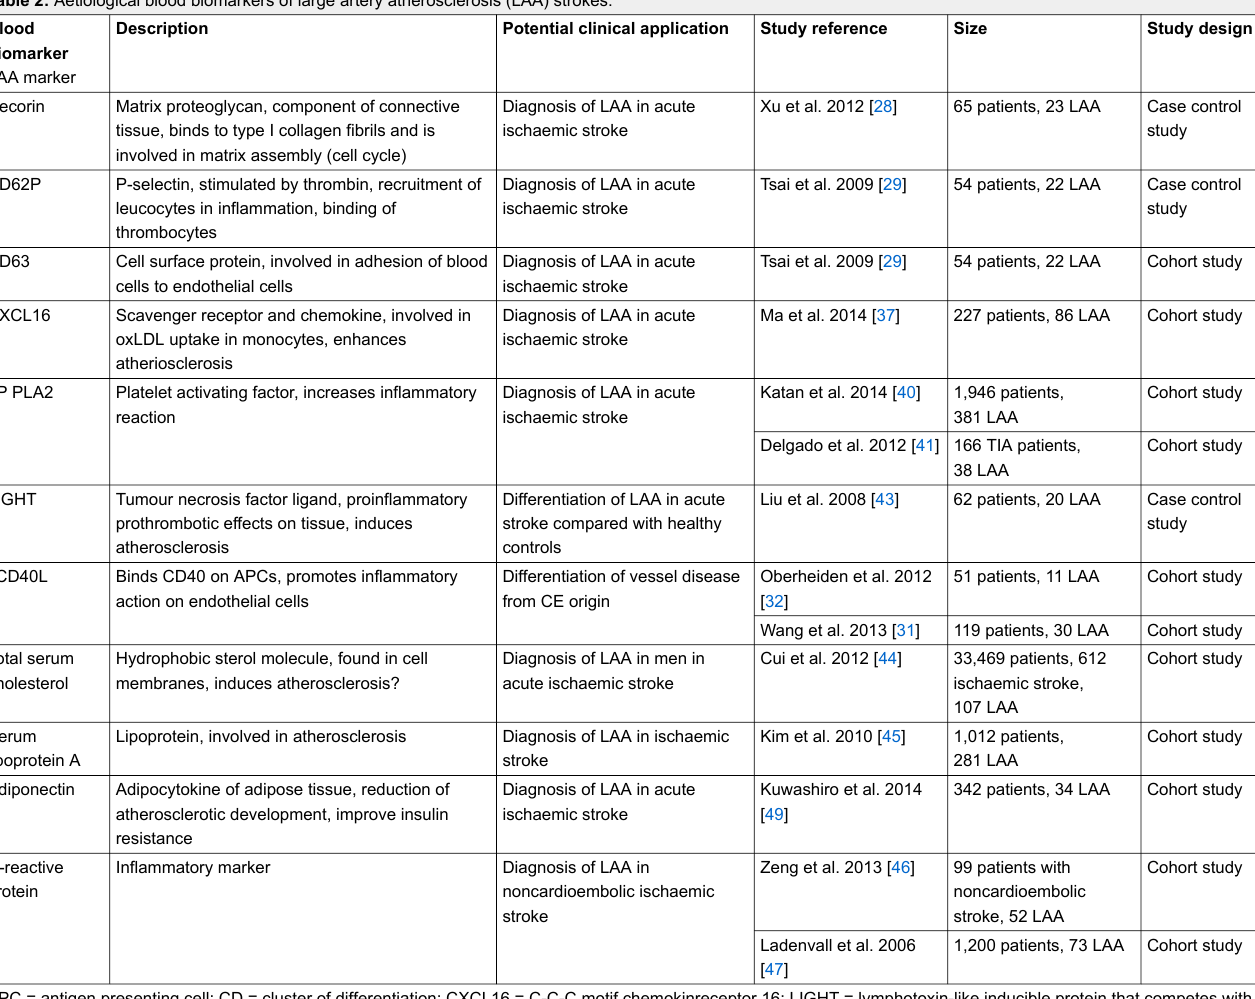
Table 2: Aetiological blood biomarkers of large artery atherosclerosis (LAA) strokes. Blood biomarker LAA marker